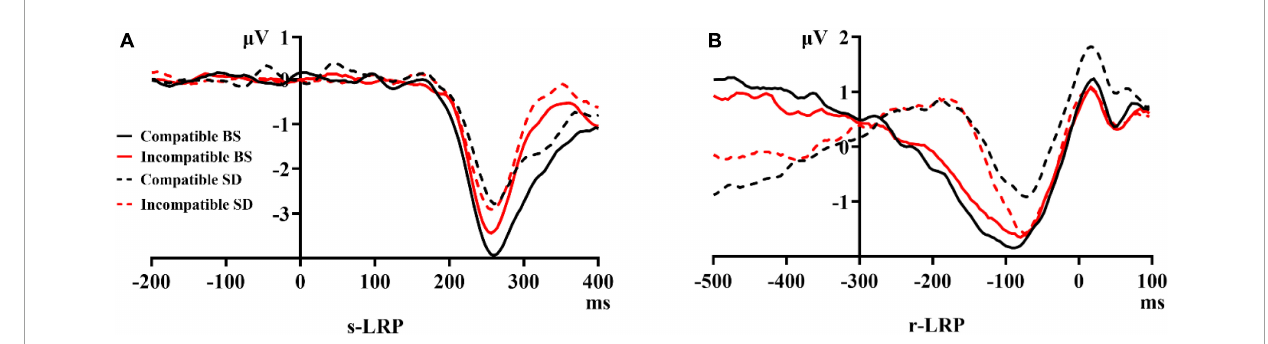
FIGURE4 Grand average waves of the s-LRP (A) and r-LRP (B) induced by the target stimulus of the stimulus-response compatibility visual search task after a full night’s sleep (at baseline) versus after total sleep deprivation (TSD). The polarity of the s-LRP induced by the incompatible stimulus was the inverse of that induced by the compatible stimulus; therefore, we inverted the polarity to compare the peak amplitudes and onset latencies of the s-LRPs between the two sleep conditions. s-LRP, stimulus-locked lateralized readiness potential; r-LRP, response-locked lateralized readiness potential; BS, at baseline; SD, after total sleep